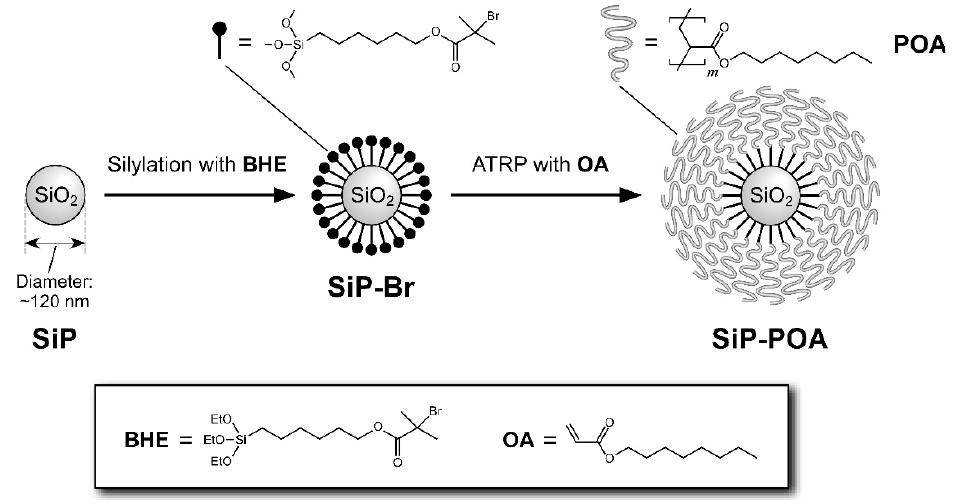
Figure 1. Schematic representation of synthesis of SiP-POA by the SI-ATRP.